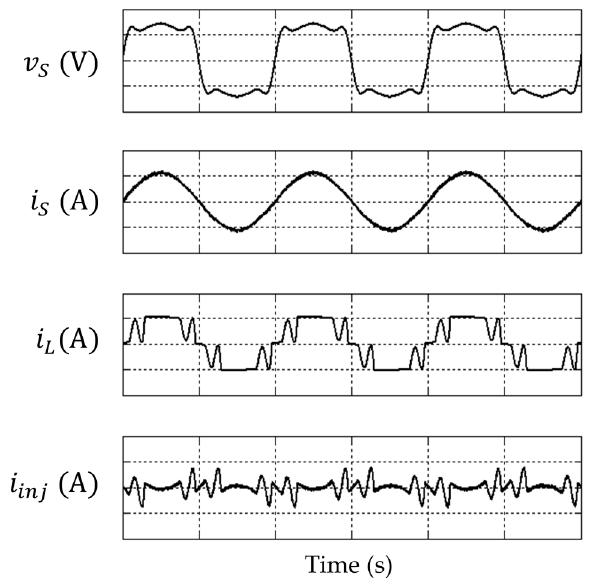
Figure 13. Theoretical waveforms (phase A) of SAPF’s operation under distorted source voltage conditions.